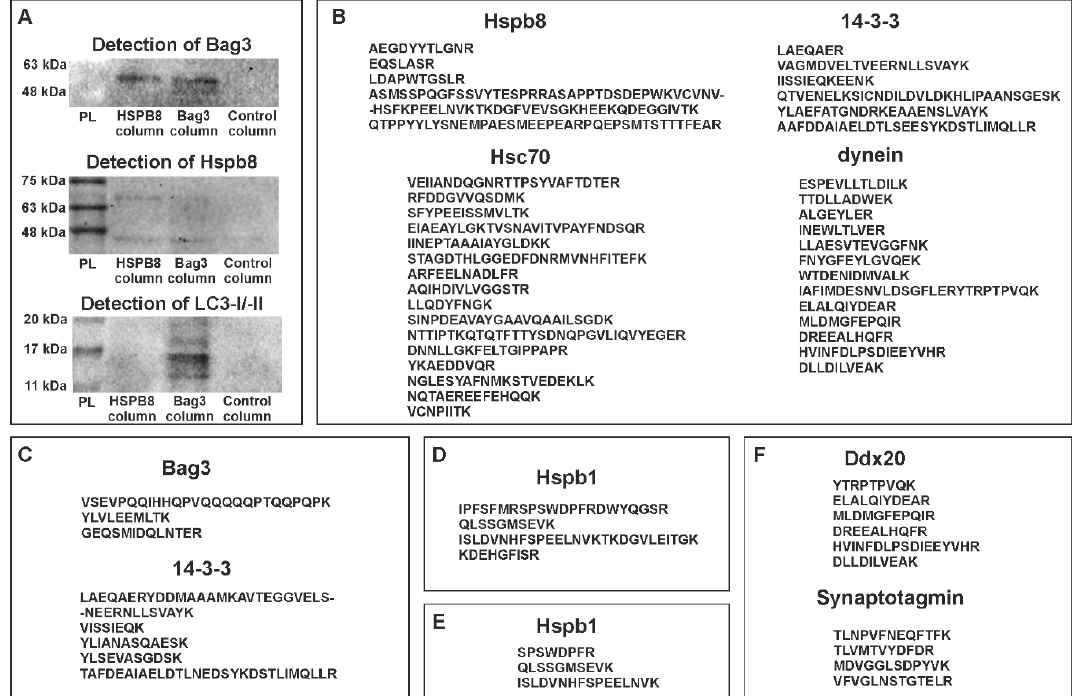
Figure 3. Protein partners of zebrafish Hspb8. ( A ) Western blot analysis of co-immunoprecipitation (co-IP) assay results. Each experiment involved the use of three columns: the first containing resin with an immobilized anti-Hspb8 antibody, the second an immobilized anti-Bag3 antibody, and the third only resin was used as a negative control. Hspb8 and Bag3 interact with each other. Moreover, Bag3 interacts with LC3 I/II. ( B ) and ( C ), List of peptides representing proteins involved in the formation of the autophagy-inducing complex detected by LC-MS analysis of eluates obtained from the co-IP experiment conducted using the column with an immobilized anti-Bag3 antibody ( B ), anti-Hspb8 antibody ( C ). ( D ) and ( E ), List of peptides representing Hspb1 detected by LC-MS analysis of eluates obtained from the co-IP experiment conducted using the column with an immobilized anti-Bag3 antibody ( D ) and anti-Hspb8 antibody ( E ). ( F ) List of peptides representing neuronal proteins detected by LC-MS analysis of eluates obtained from the co-IP experiment conducted using the column with an immobilized anti-Hspb8 antibody.